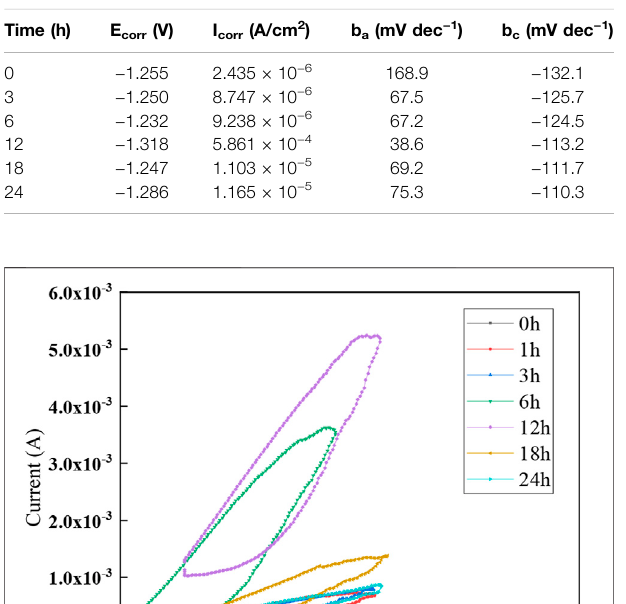
FIGURE 10 | The cyclic voltammetry curves after different immersion time.